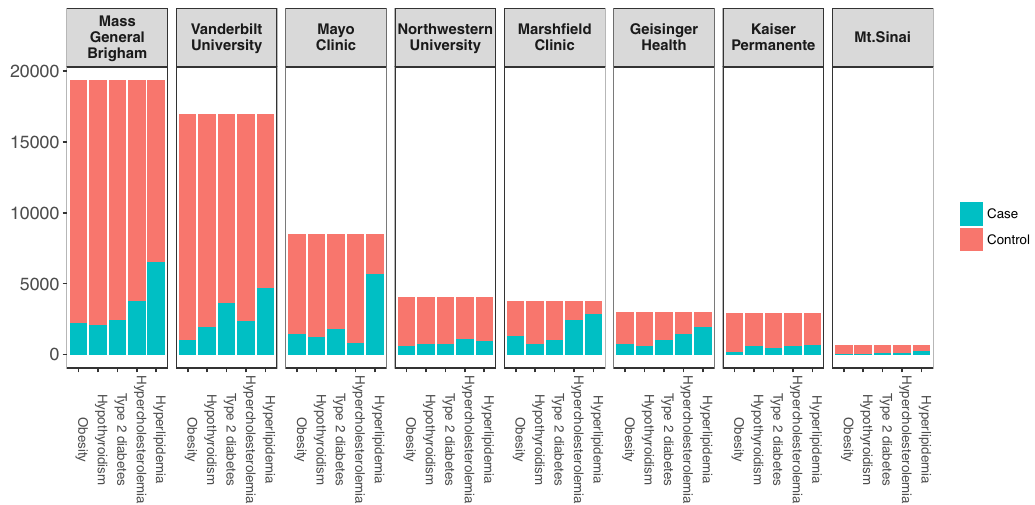
Fig. 4 Disease prevalence of cardiovascular traits in eight EHRs. The patients ’ case statuses were obtained using the following ICD-9 diagnosis codes: Obesity (ICD-9 278.00), Hypothyroidism (ICD-9 244.9), Type 2 diabetes (ICD-9 250.00), Hypercholesterolemia (ICD-9 272.0), and Hyperlipidemia (ICD-9 272.4). Each panel displays the disease prevalence for an EHR.